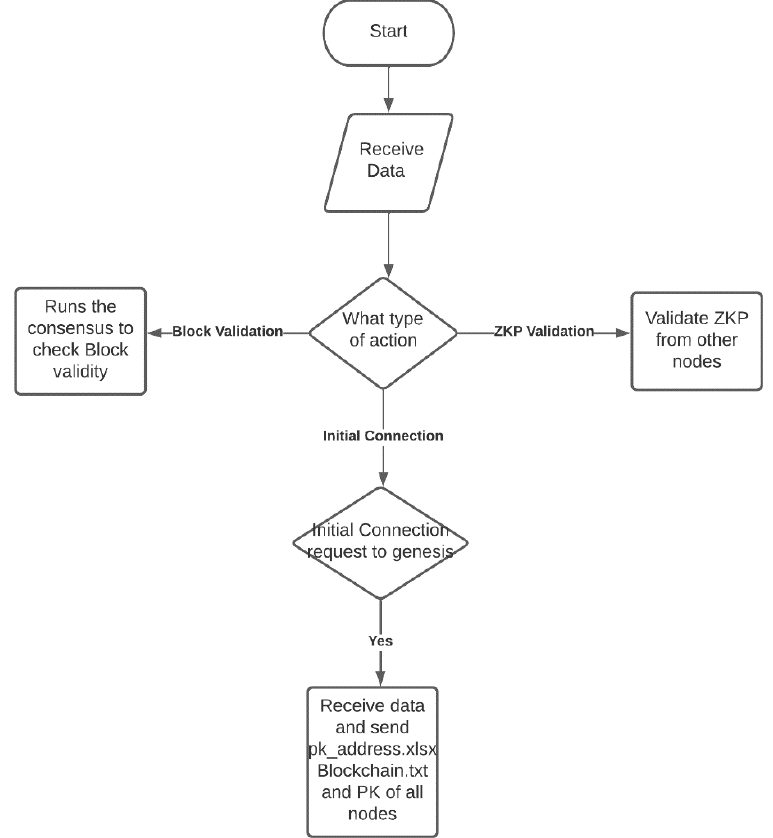
Figure 4. Receiving